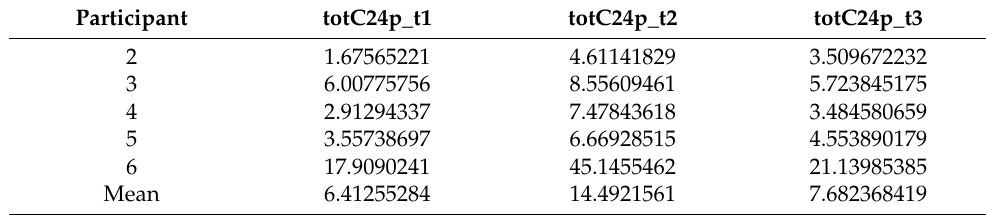
Table 29. TotC24, pudding 10 mL (%C2–4) individual and mean measurements at three assessment time points.